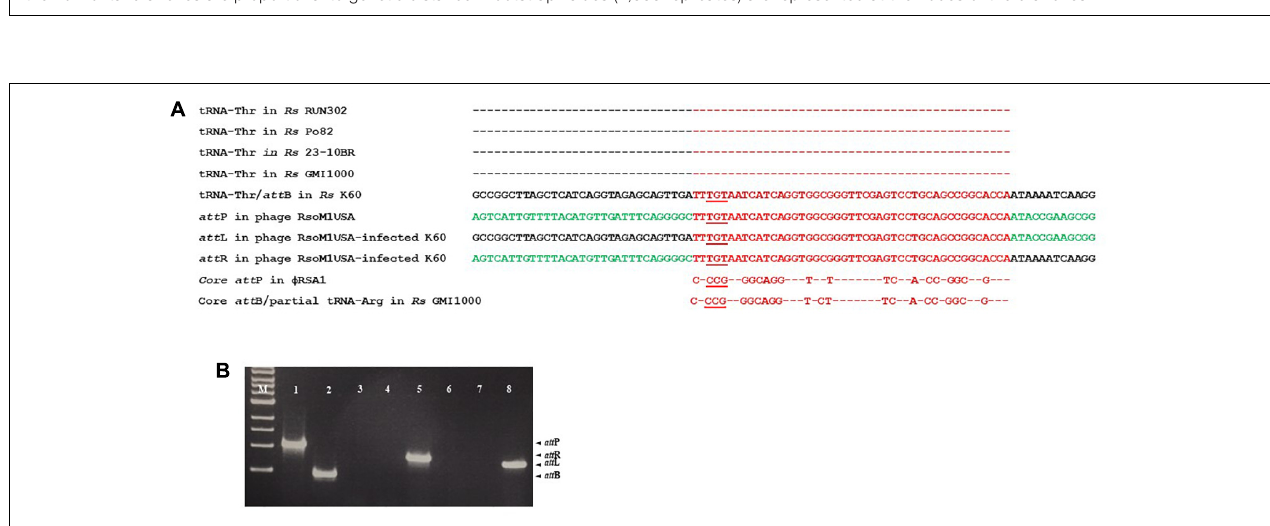
FIGURE 4 | Phylogenetic relationships between Ralstonia phage RsoM1USA and 13 other phages of the genus P2virus (under the subfamily Peduovirinae of the family Myoviridae ) including Ralstonia virus RSA1 (phage RSA1), based on deduced amino acid sequences of phage capsid protein (A) , terminase ATPase subunit protein (B) , and phage portal protein (C) , as well as between RsoM1USA and 12 phages based on annotated integrase (D) . The phylogenetic trees were generated using the downloadable alpha-test version of PAUP (Phylogenetic Analysis Using PAUP) (http://phylosolutions.com/paup-test). Vertical distances are arbitrary, but the horizontal branches are proportional to genetic distance. Bootstrap values (1,000 replicates) are represented at the nodes of the branches.